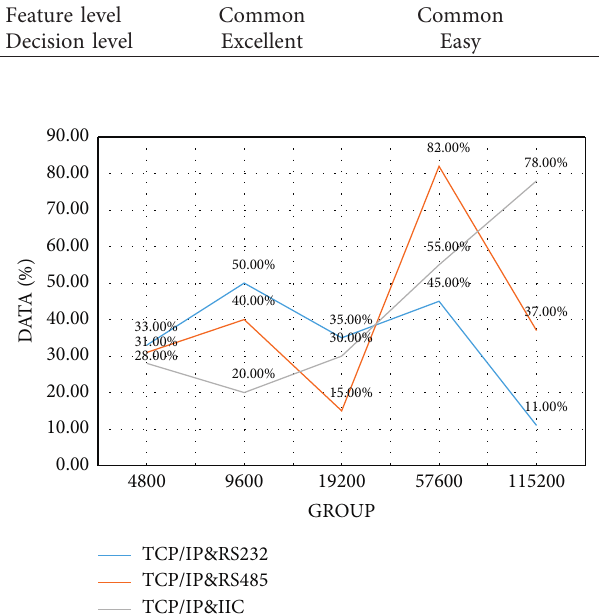
Figure 3: The delay between the subcontrol node and the main